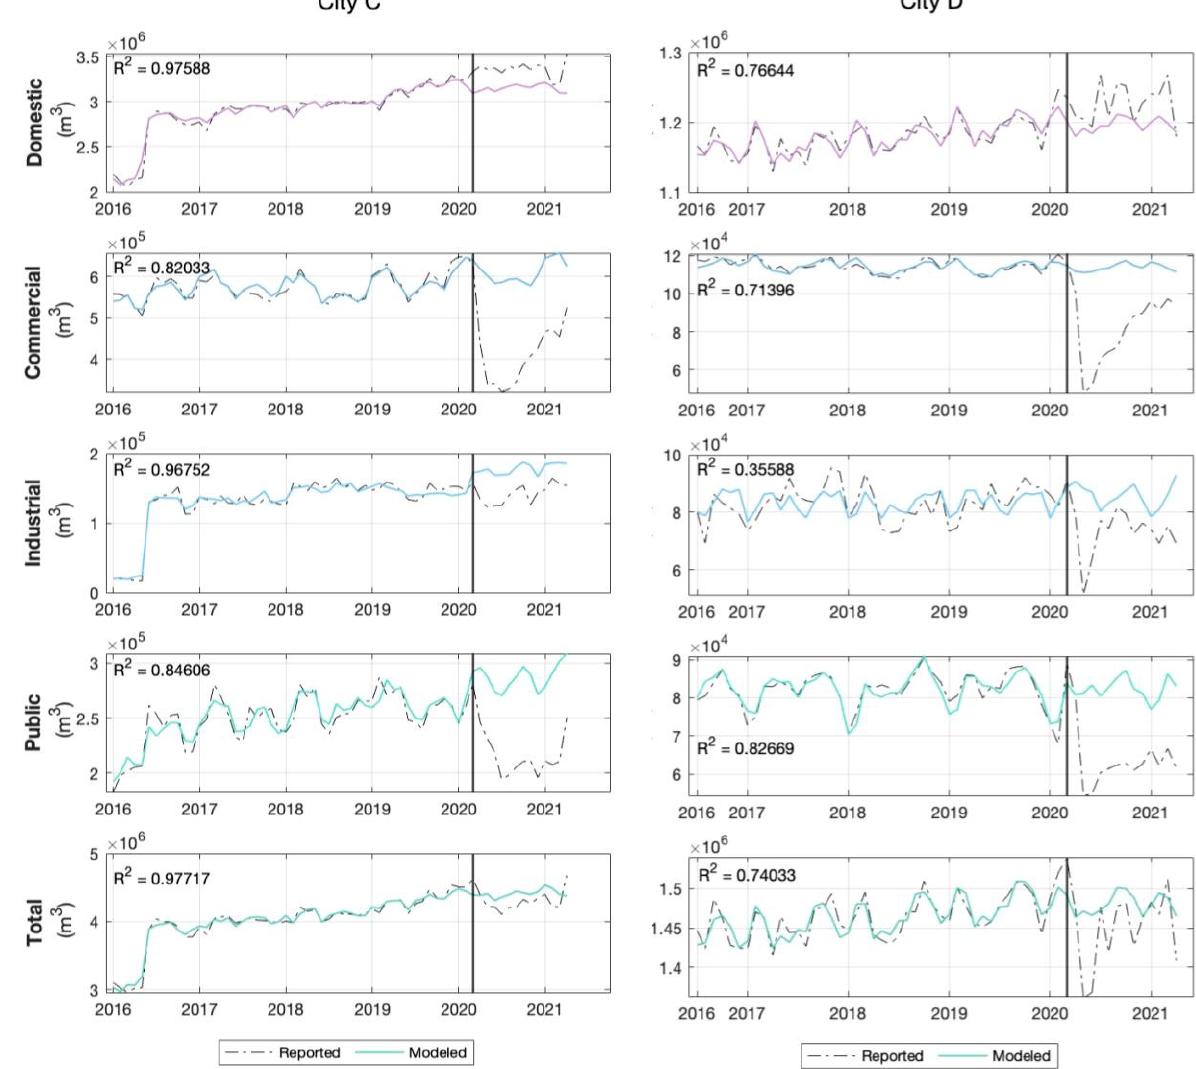
Figure 3. Actual water consumption (Reported) and model predictions (Modeled) by water demand category for Cities A and B. Actual water consumption (Reported) and model predictions (Modeled) by water demand category for Cities C and D (in cubic meters). The multivariate regression model’s accuracy is shown through pre-pandemic data (before black vertical lines) and the corresponding R-squared values. Pandemic data and predictions are presented after the black vertical lines.